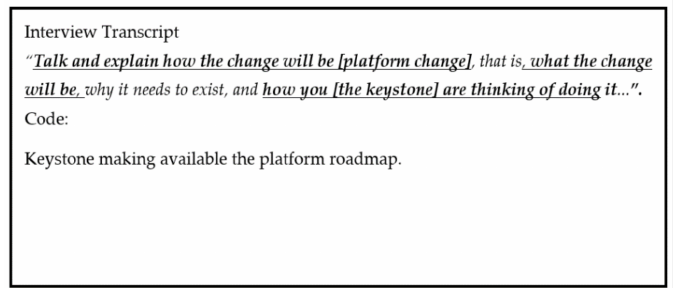
Figure 3. Open coding: creating codes.